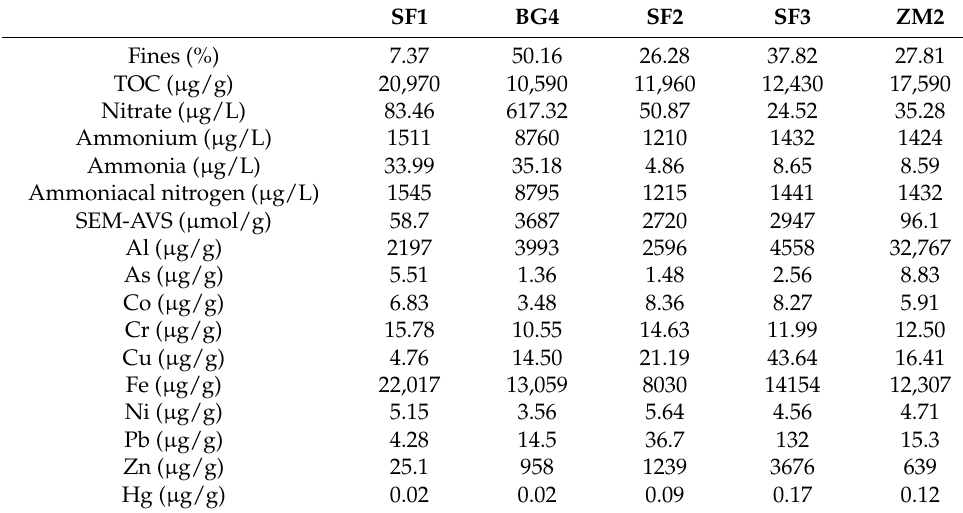
Table 1. Summarized results of physicochemical parameters analyzed in sediments from the San Francisco River (SFR): percentage of fines, total organic content (TOC), nitrogen species (nitrate, ammonium, ammonia, and ammoniacal nitrogen), SEM-AVSs, and metal(loid) concentrations (Al, As, Co, Cr, Cu, Fe, Ni, Pb, Zn, and Hg). SF1